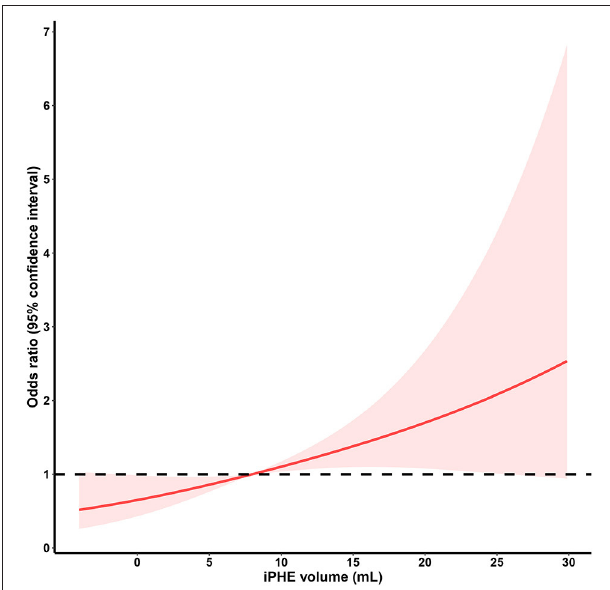
FIGURE 2 | Restricted cubic spline analysis of the association between iPHE volume and poor outcome OR (The middle solid line indicates the point estimates of odds ratios and the shaded part indicate the lower and upper limits of the corresponding 95% confidence intervals. The horizontal dashed line was at odds ratio = 1 (reference point: 7.98mL). Three knots were used for the restricted cubic spline analysis).